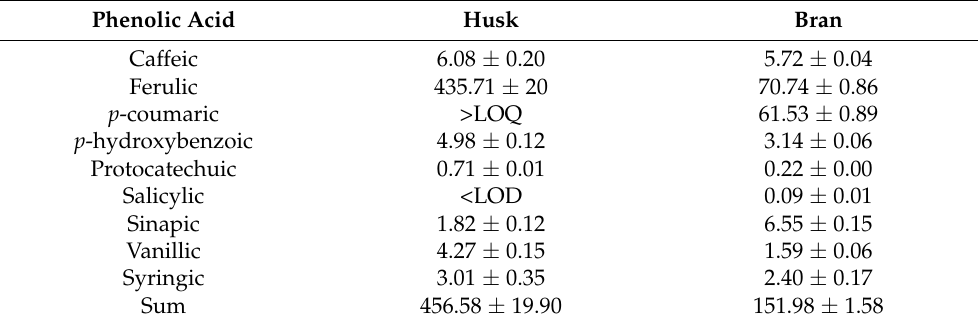
Table 2. Comparison of The Basic Composition of Oat Husk and Bran (g/100 g